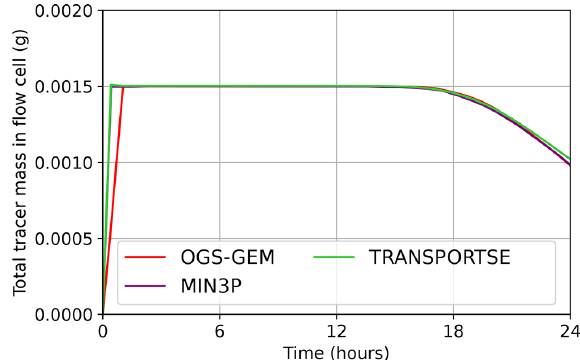
Figure 4. Temporal development of total tracer mass in flow cell calculated by TRANSPORTSE-PHREEQC in comparison against the results produced by MIN3P-THCm and OpenGeoSys-GEM (Poonoosamy et al.,